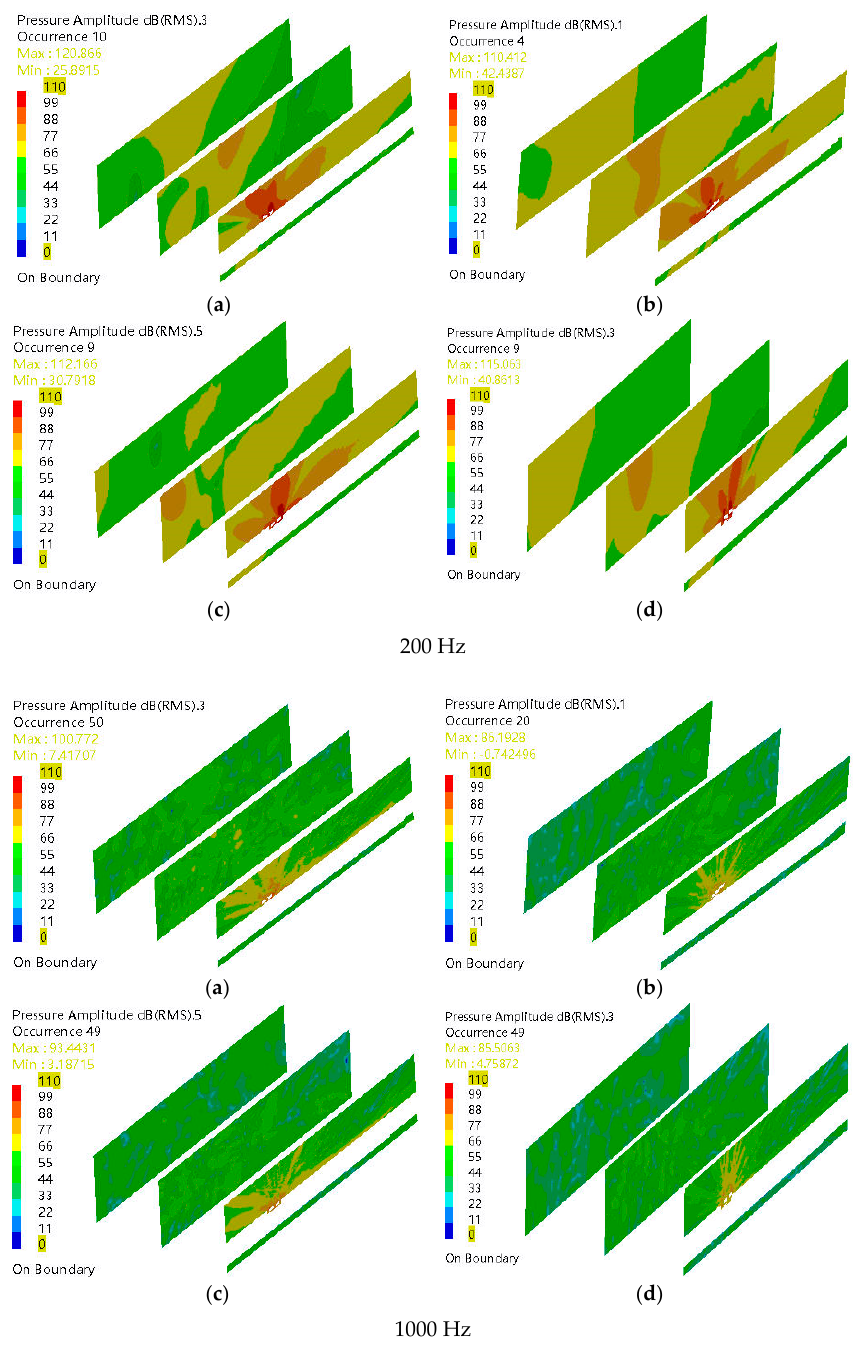
Figure 16. Spatial distribution of near-field (Y = 0 m) and far-field (Y = 10 m, Y = 20 m) noise at 200 Hz and 1000 Hz on: ( a ) down-pantograph with flush base; ( b ) up-pantograph with flush base; ( c ) down-pantograph with sunken base; and ( d ) up-pantograph with sunken base.